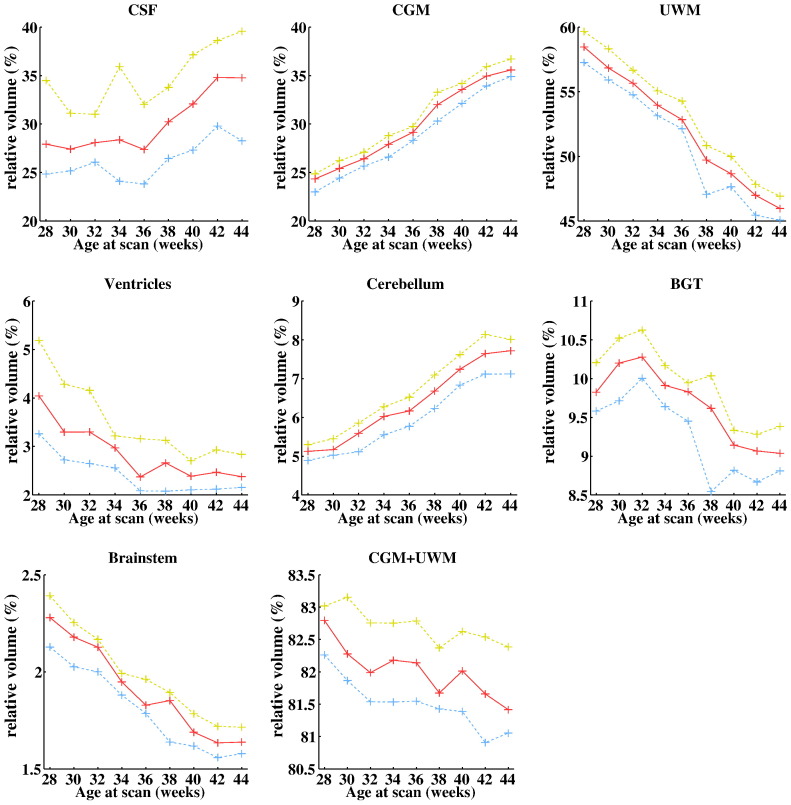
Relative volume (ratio of structure's volume to the total brain volume) centiles of tissues with increasing scan age. The yellow line for each region represents the 25% centile over the subjects in the database, the red line the median value, and the blue line the 75% centile.